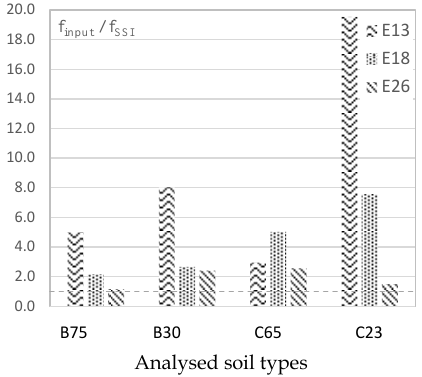
Figure 9. Comparison between the input frequencies f input and the soil frequencies f SSI (evaluated considering the SS alignment).